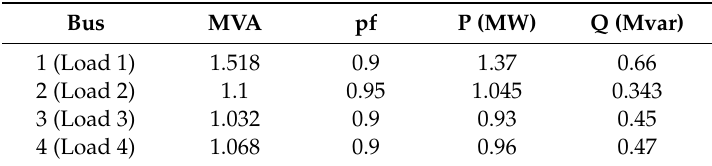
Table 1. Non-Critical Load Data.